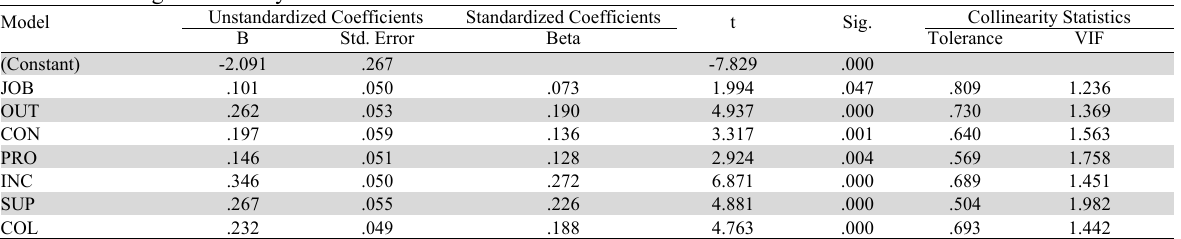
The results of regression